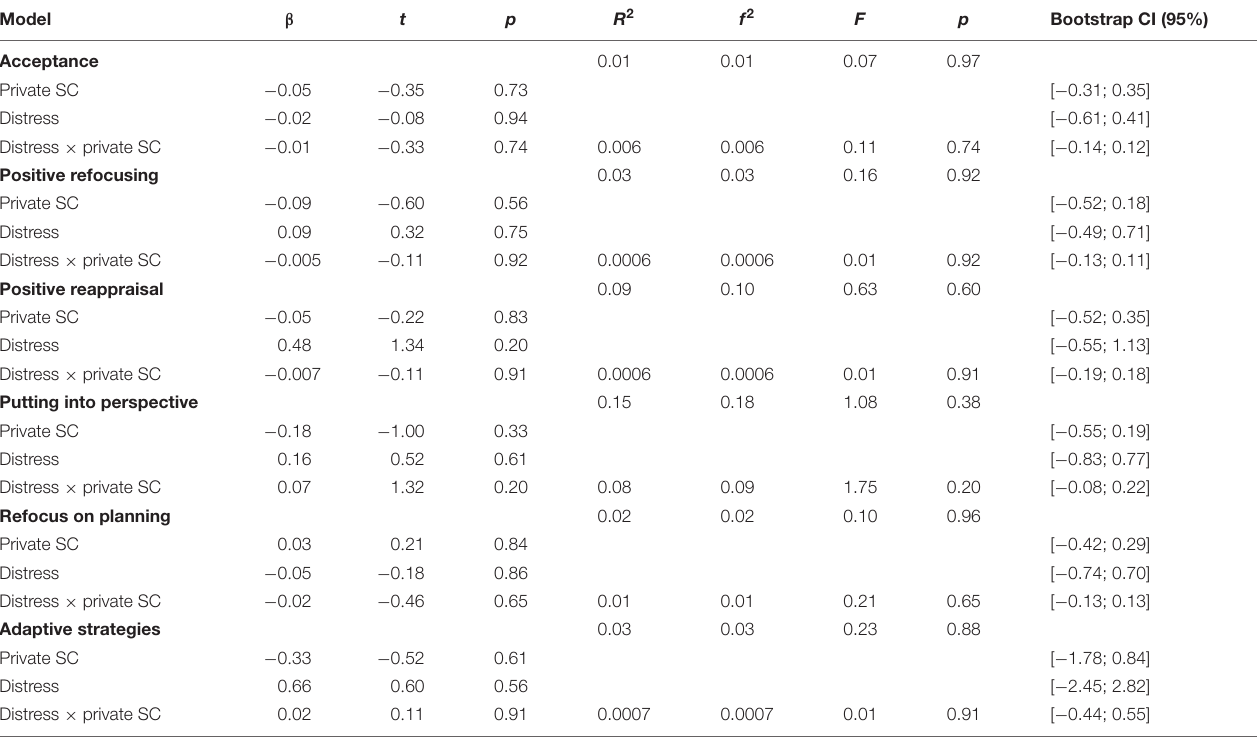
TABLE 8 | Multiple regression analyses predicting adaptive emotion regulation strategies as a function of private SC, distress and their interaction in the control